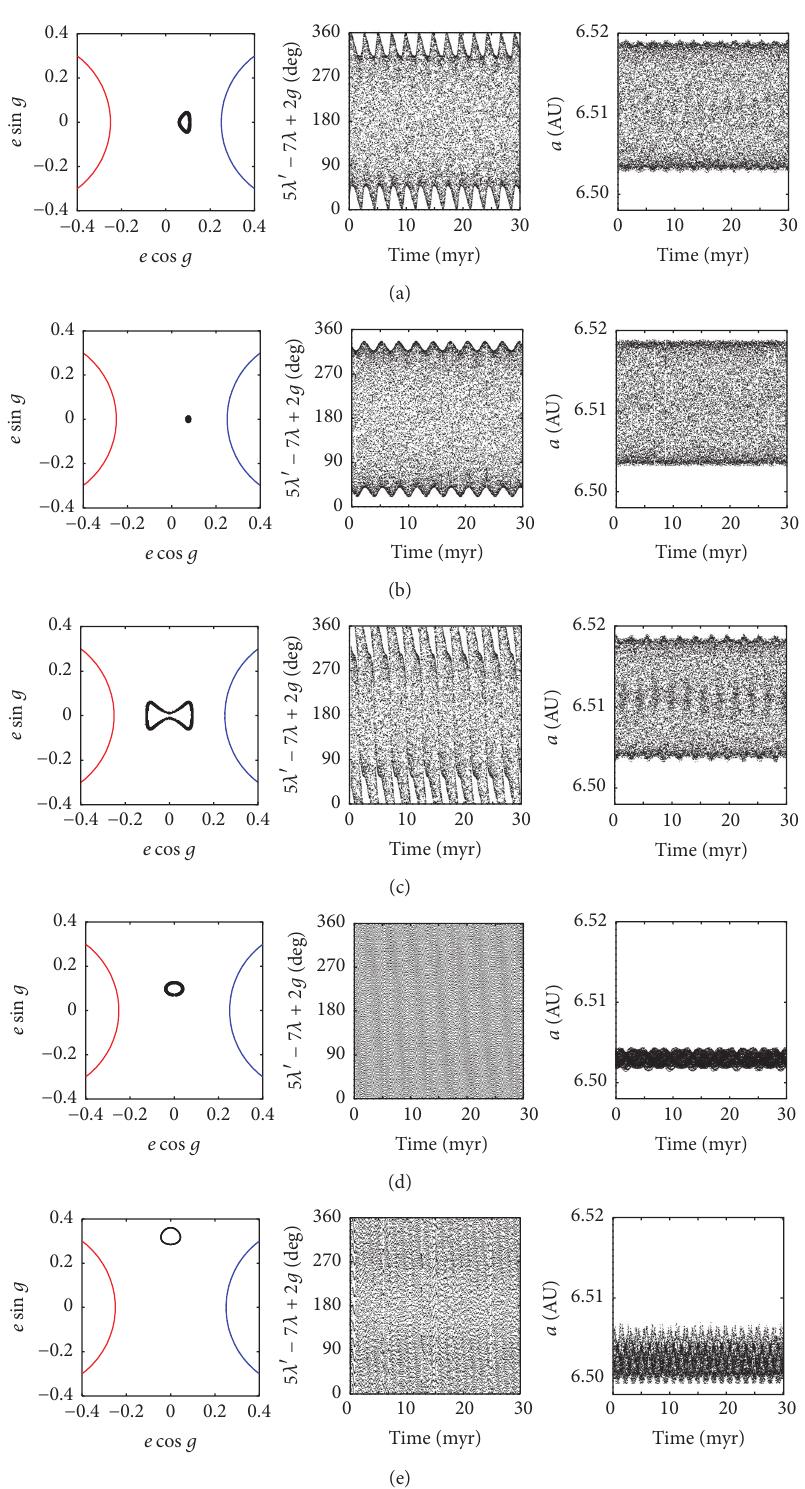
Figure 5: Some of the peculiar periodic orbits seen in Figure 4(b). The initial 𝑒 and 𝑔 are as follows: (a) (𝑒, 𝑔) = (0.06, 0) , (b) (𝑒, 𝑔) = (0.08, 0) , (c) (𝑒,𝑔) = (0.10, 0) , (d) (𝑒, 𝑔) = (0.07, 𝜋/2) , and (e) (𝑒, 𝑔) = (0.36, 𝜋/2) . The left column: the usual (𝑒 cos 𝑔, 𝑒 sin 𝑔) plots. As for the meaning of the red and blue partial circles, see the caption of Figure 2. The middle column: the argument 5𝜆 󸀠 − 7𝜆 + 2𝑔 plotted with a time interval of 1500 years. The right column: osculating semimajor axis 𝑎 plotted with an interval of 1500 years. All the orbital elements are calculated on the heliocentric coordinate centered on the central